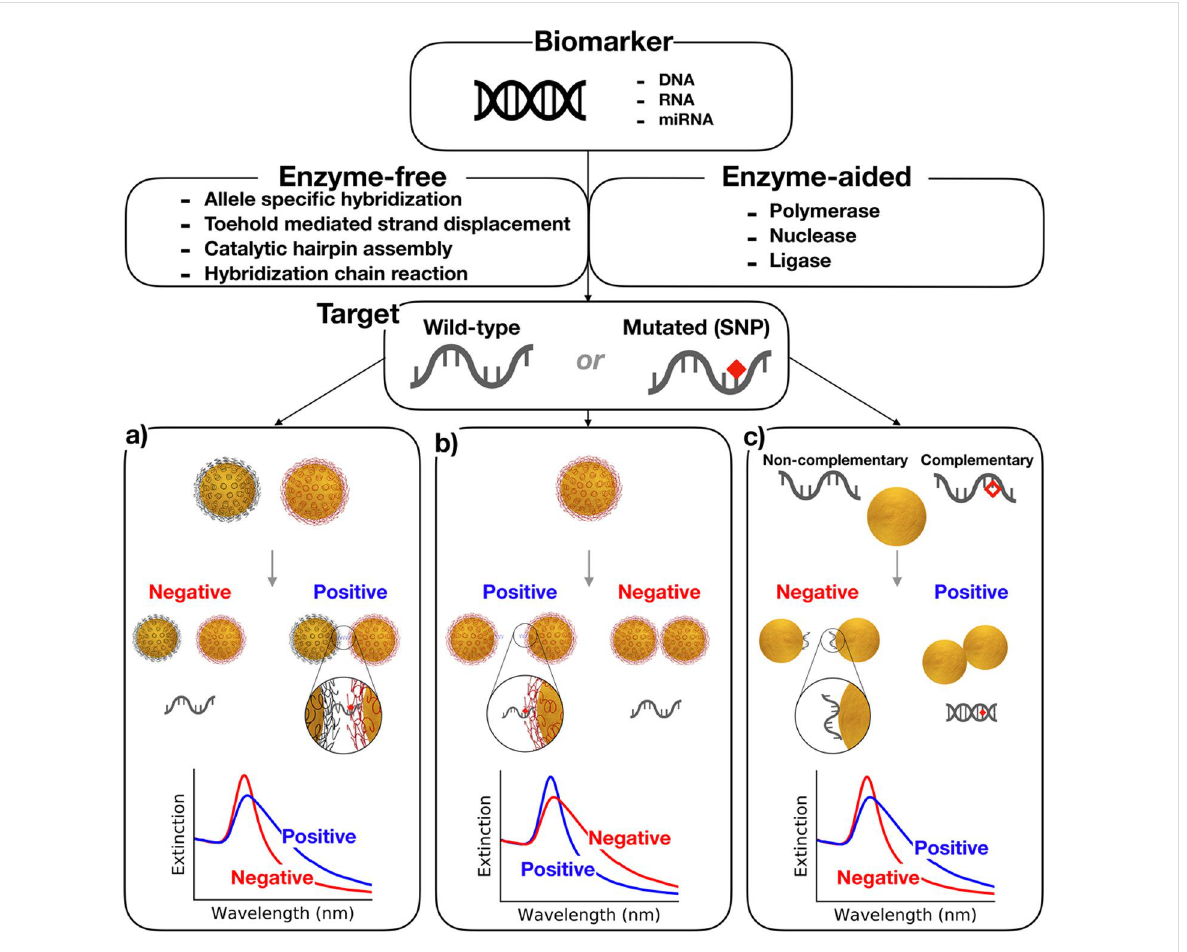
Figure 3: Gold nanoparticle-based colorimetric assays in the colloidal phase. a) Cross-linking hybridization assay: Through the specific hybridization of DNA, the distance between the particles decreases leading to a color change. b) Noncross-linking hybridization assay: An increase in the ionic strength causes an aggregation of nanoparticles (blue solution), which is prevented by the presence of the complementary target. c) Colorimetric assay based on unmodified nanoparticles: Single-stranded DNA (ssDNA) stabilizes gold nanoparticles against salt-induced aggregation, while in the presence of double-stranded DNA (dsDNA) particles undergo